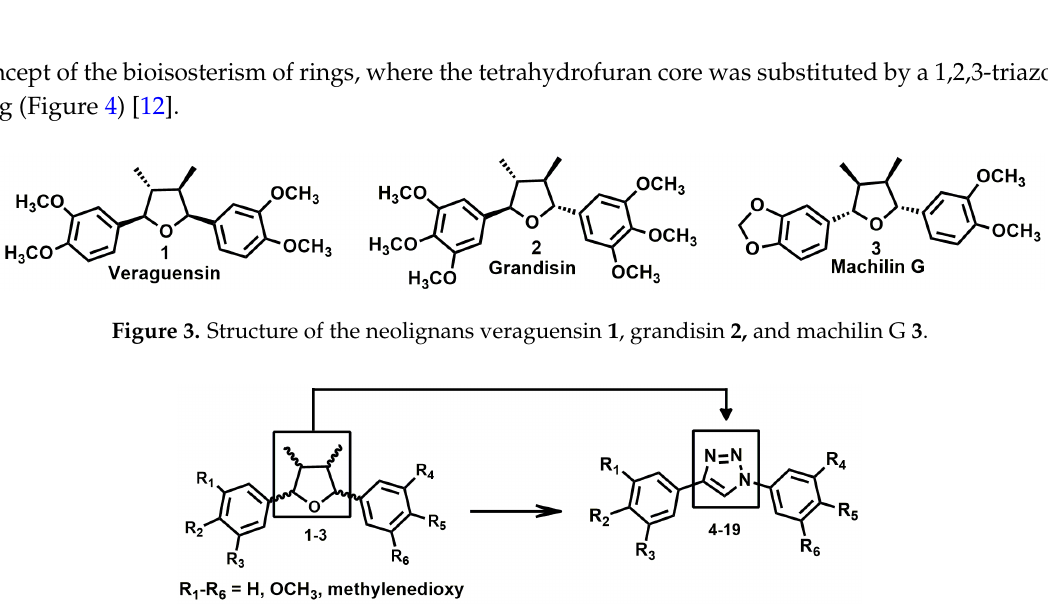
Figure 4. Structural design of 1,4-diaryl-1,2,3-triazole derivatives of the neolignans 1 – 3 .